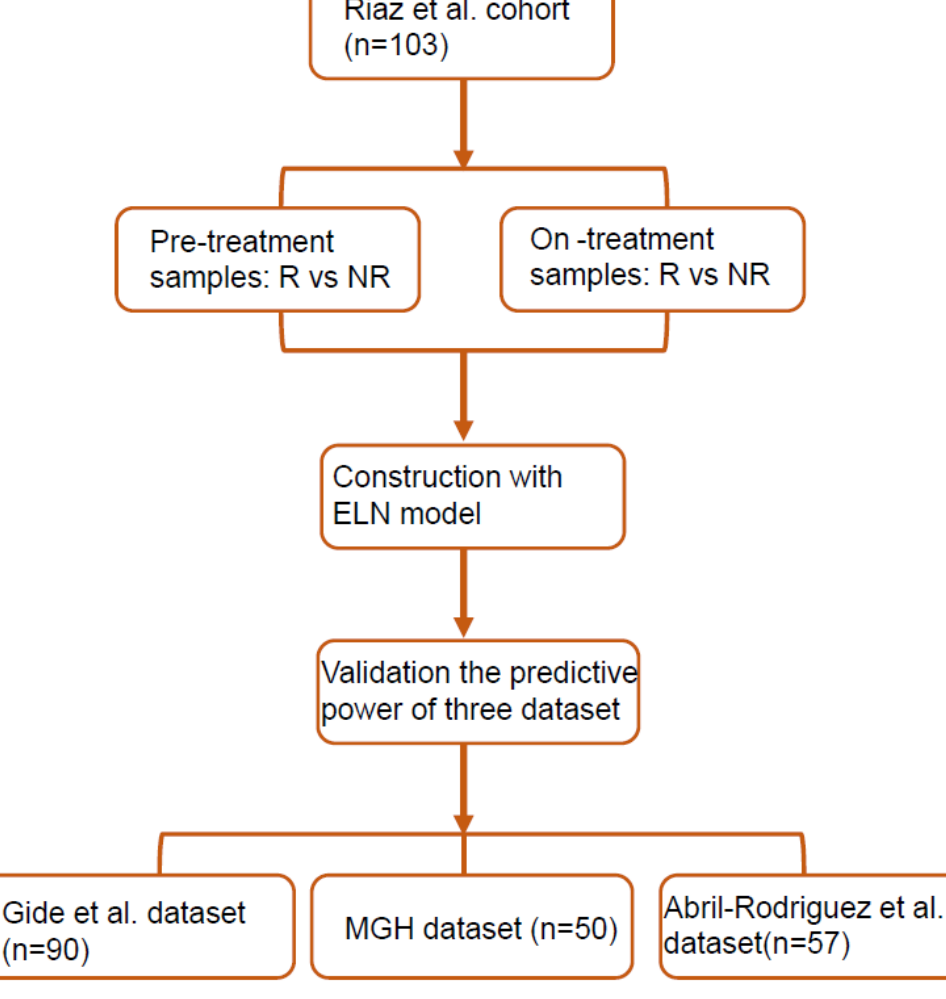
Figure 1. The flow chart of FGE signature score construction.